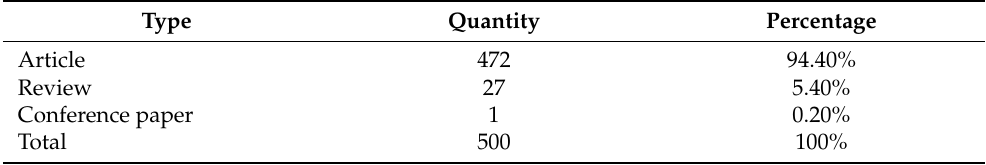
Table 1. Types and Quantities of Jurnal Pengurusan Publications (2006–2021).